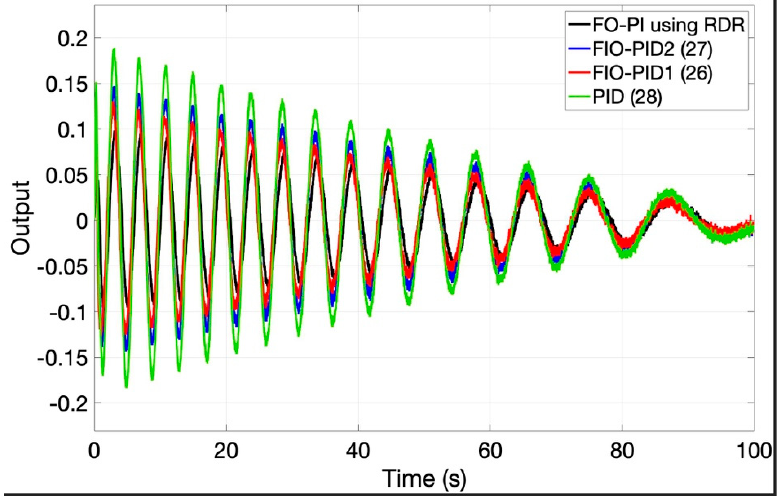
Figure 26. Disturbance rejection results for an unstable time delay process considering a swept sinusoidal disturbance signal with frequencies in [0.25 ω d , 2 ω d